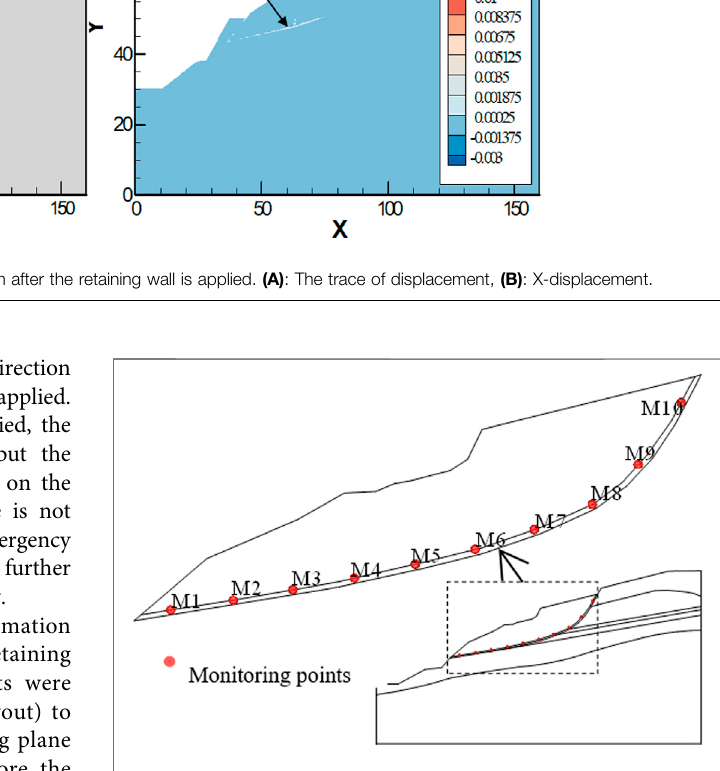
FIGURE 7 | Layout of monitoring